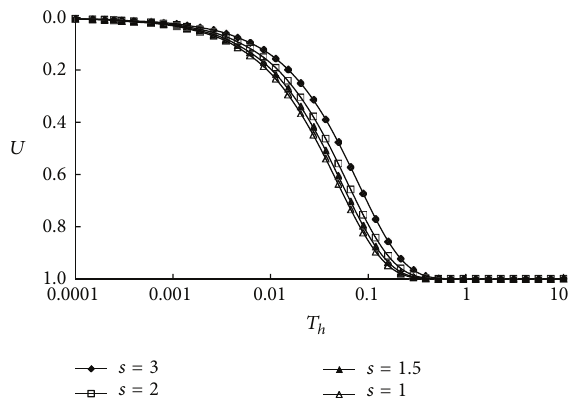
Figure 10: Influence of 𝑠 on consolidation process.